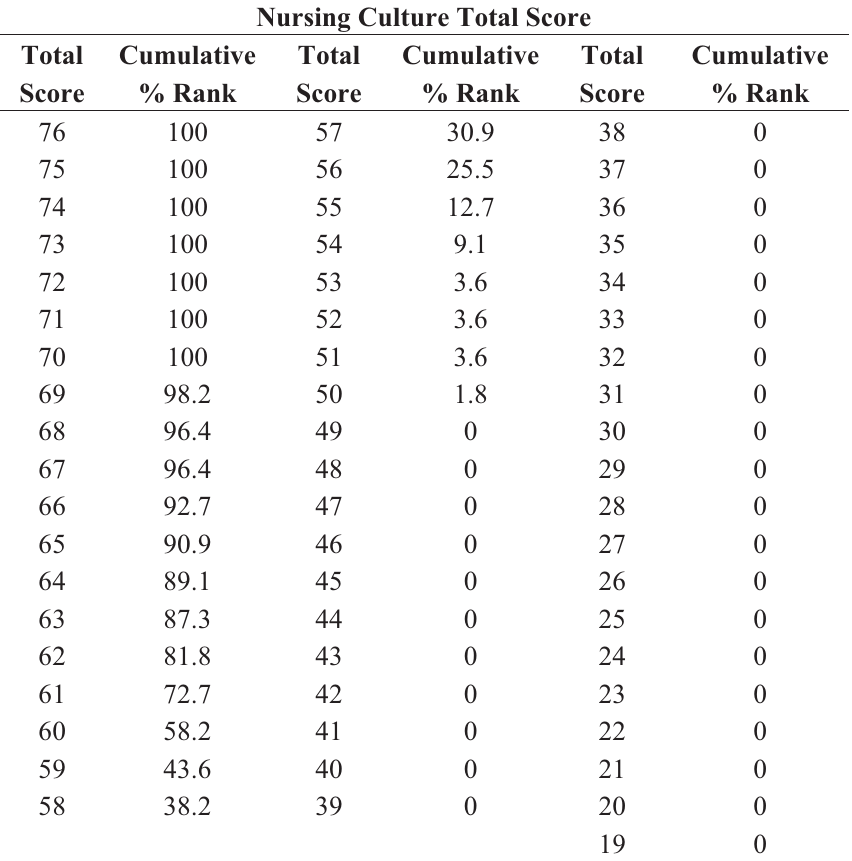
Table 3. Cumulative Rank Percentage of Facility Scores on Nursing Culture Total Score.